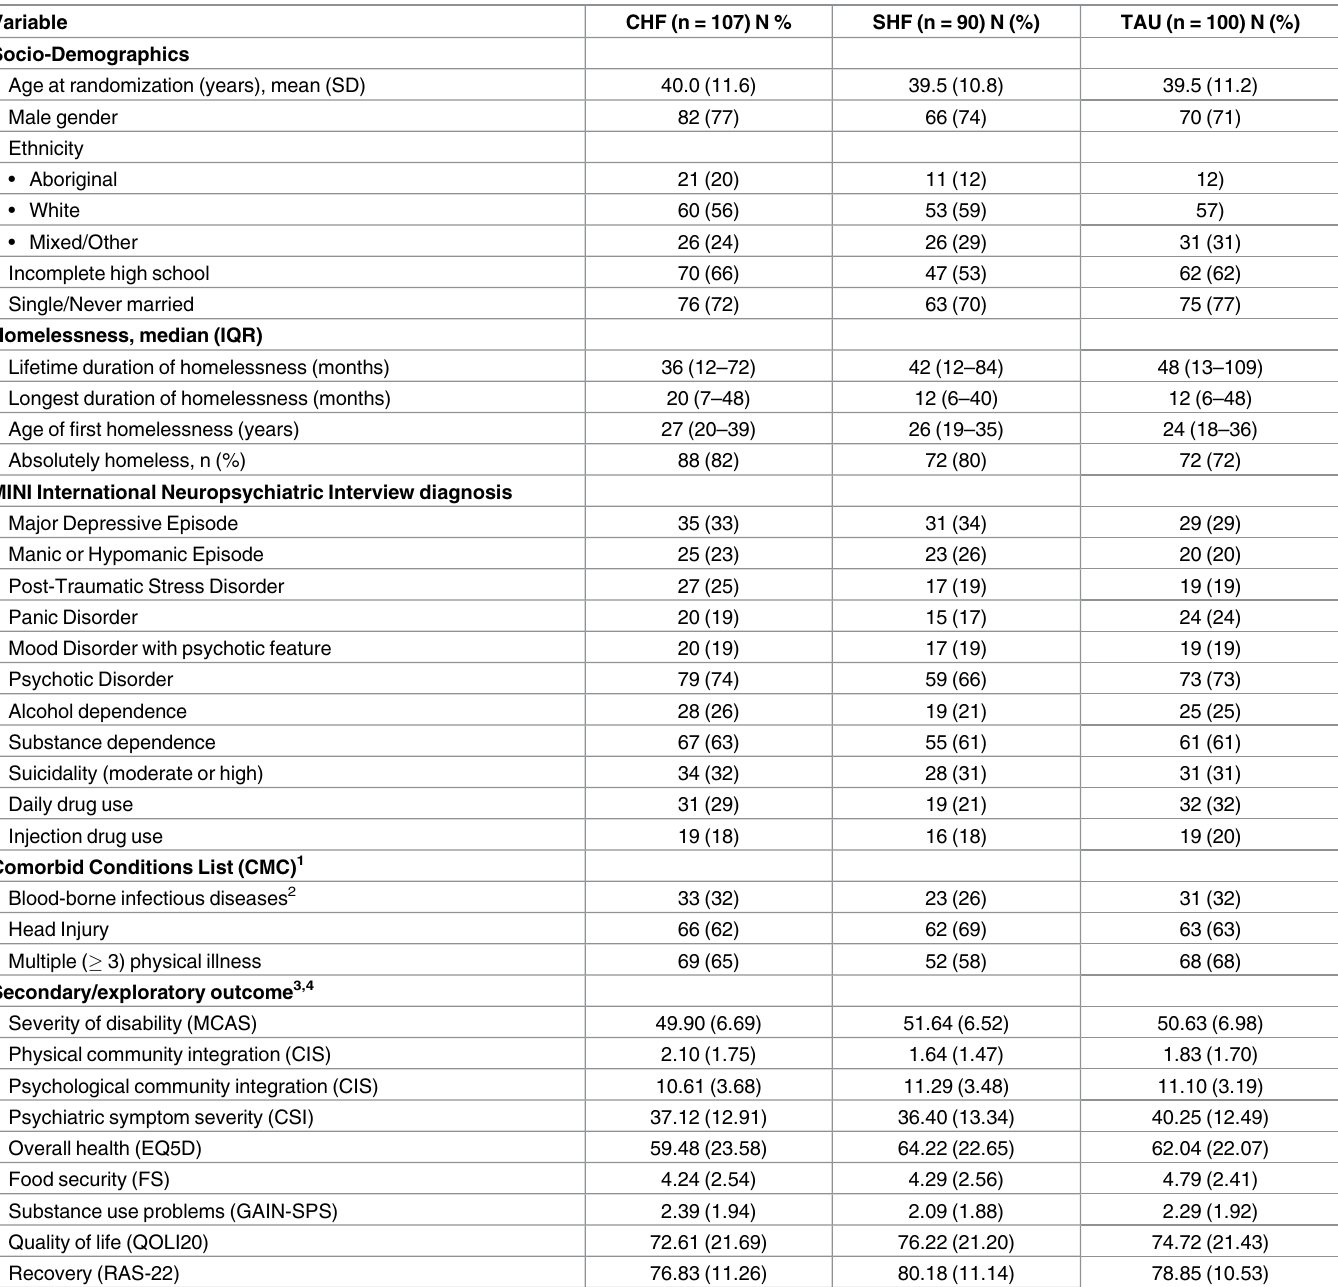
Table 1. Characteristics of VAH participants at enrolment visit